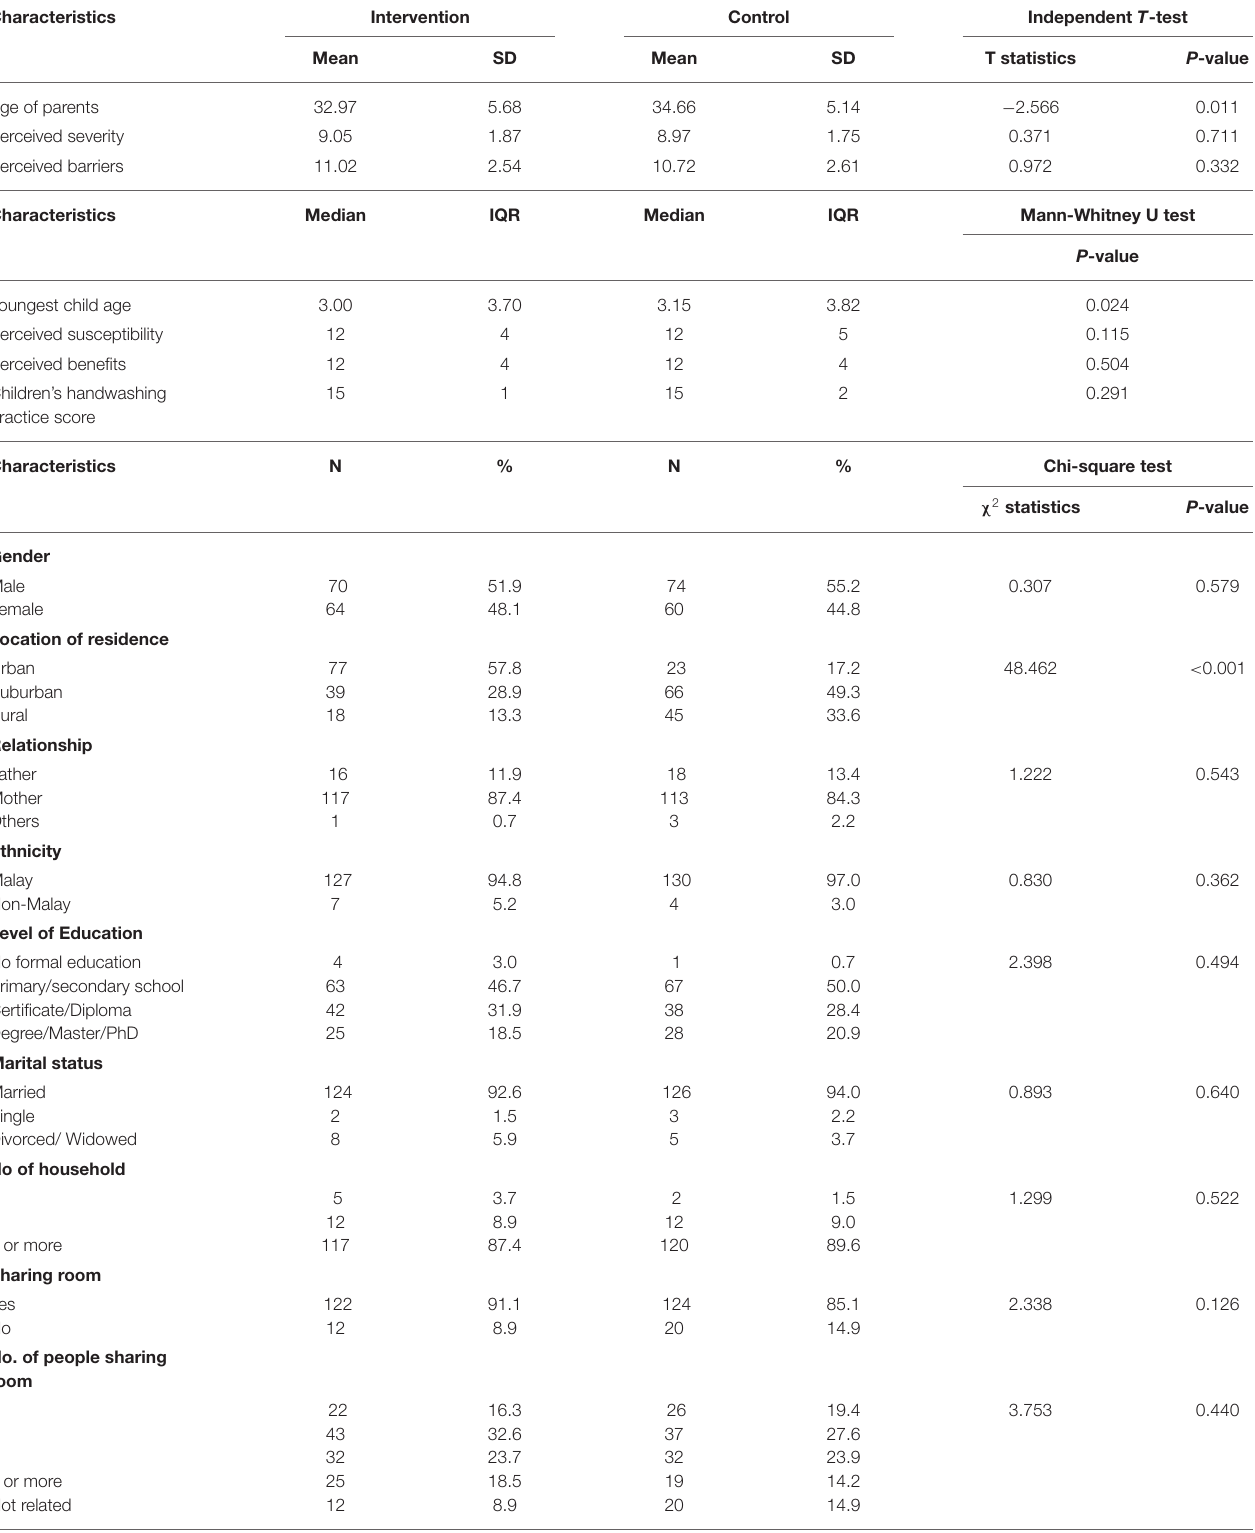
TABLE 1 | Baseline comparison of socio-demographic, household characteristics and parent’s perception and children’s handwashing practice ( n = 268).